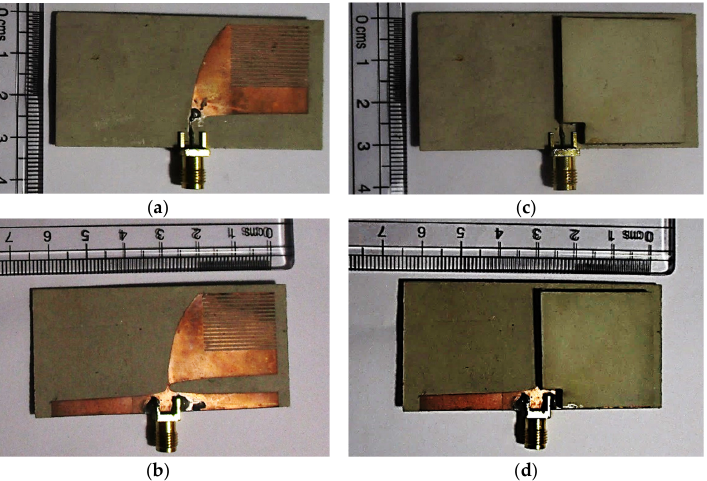
Figure 18. Fabricated prototype of the proposed antenna 2: ( a ) top layer without the superstrate, ( b ) bottom layer without the superstrate, ( c ) top layer with the superstrate, ( d ) bottom layer with the